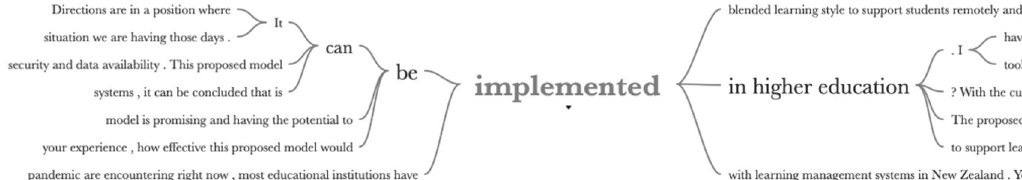
Fig. 7 Stemmed word query for “ implemented